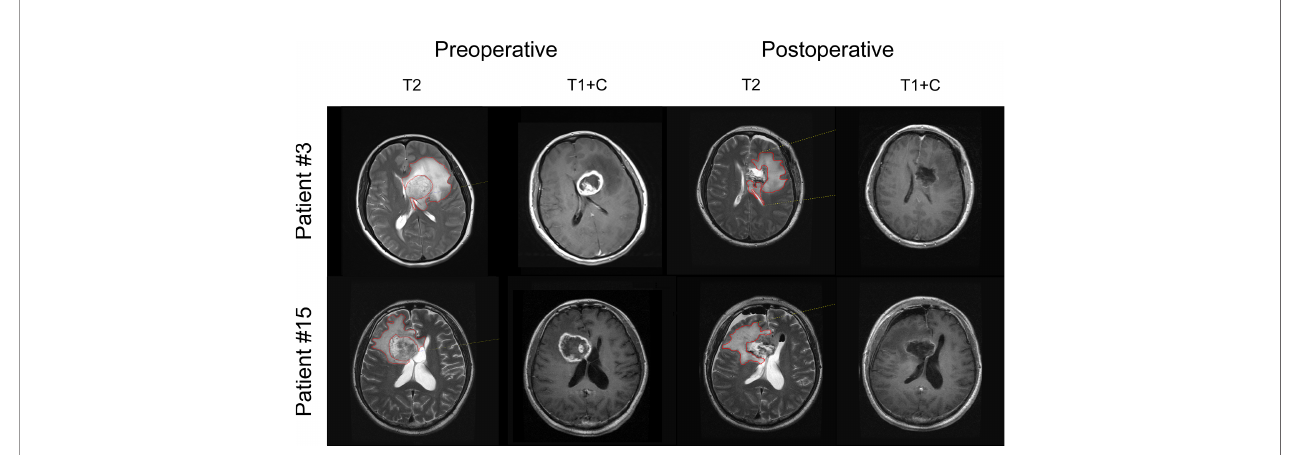
FIGURE 1 | T2-EOR determination on preoperative and postoperative MRI images. The noncontrast-enhancing regions were represented as T2-weighted hyperintense areas outside the T1-weighted contrast-enhancing lesions and were termed T2-nonenhancing regions. T2-nonenhancing regions were manually outlined in red at each level, and the volume was automatically calculated by Neusoft PACS software. T2-EOR was de fi ned as the preoperative-to-postoperative change in T2-nonenhancing region volume divided by the preoperative T2-nonenhancing region volume.